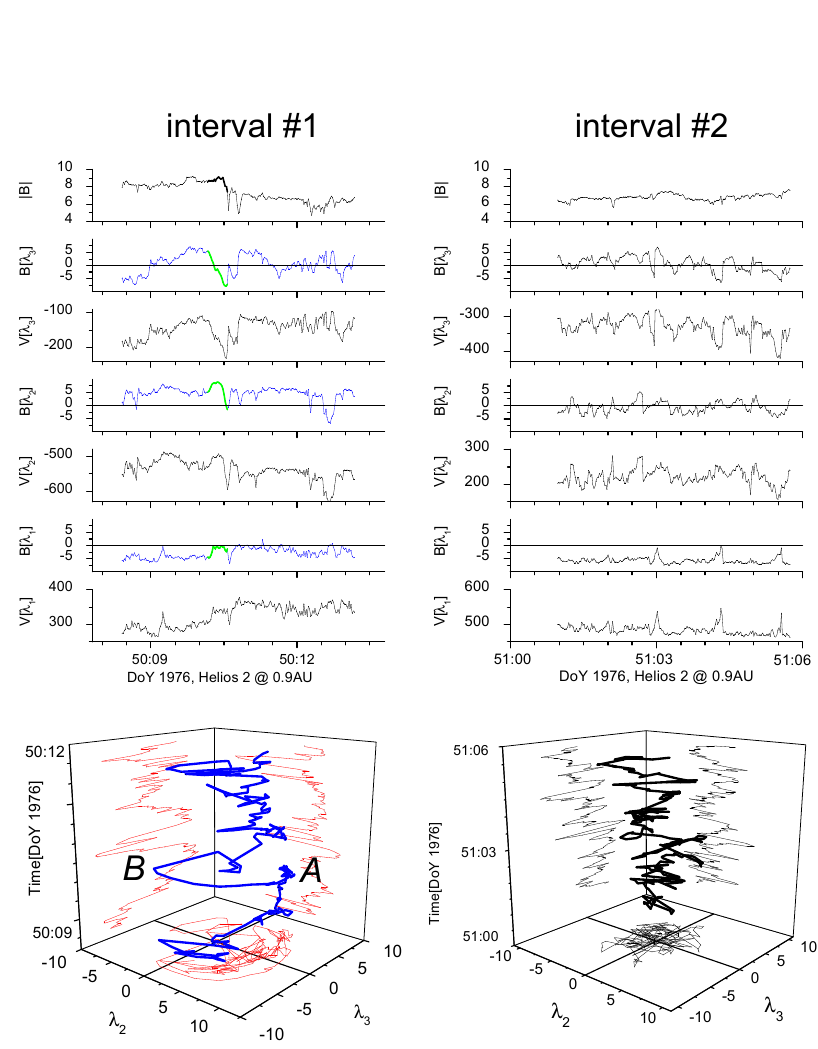
Figure 97: Left column, from top to bottom: we show magnetic field intensity, maximum 𝜆 3 , intermediate 𝜆 2 and minimum 𝜆 1 variance components for magnetic field (blue color) and wind velocity relative to the time interval #1 shown in Figure 96. Right below, we show the hodogram on the maximum variance plane 𝜆 3 − 𝜆 2 , as a function of time (blue color line). The red lines are the projection of the blue line. The large arc, from A to B , corresponds to the green segment in the profile of the magnetic field components shown in the upper panel. The same parameters are shown for interval #2 (Figure 96), in the same format, on the right hand side of the figure. The time resolution of the data is 81 s. Image reproduced by permission from Bruno et al. (2001), copyright by